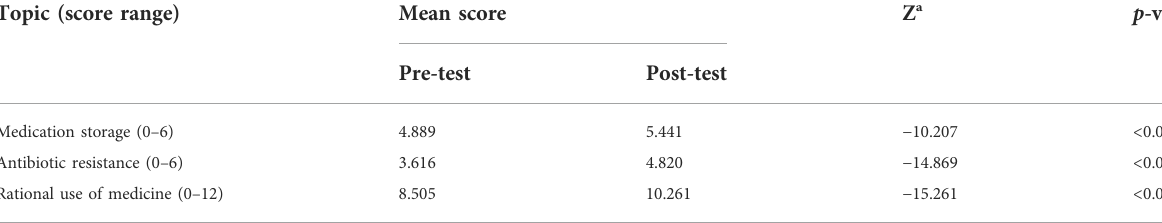
TABLE 5 Result of analysis of the effect of Dimana Ubat Olah? And Misi Melawan Raksasa Kuman video on Children ’ s knowledge. Topic (score